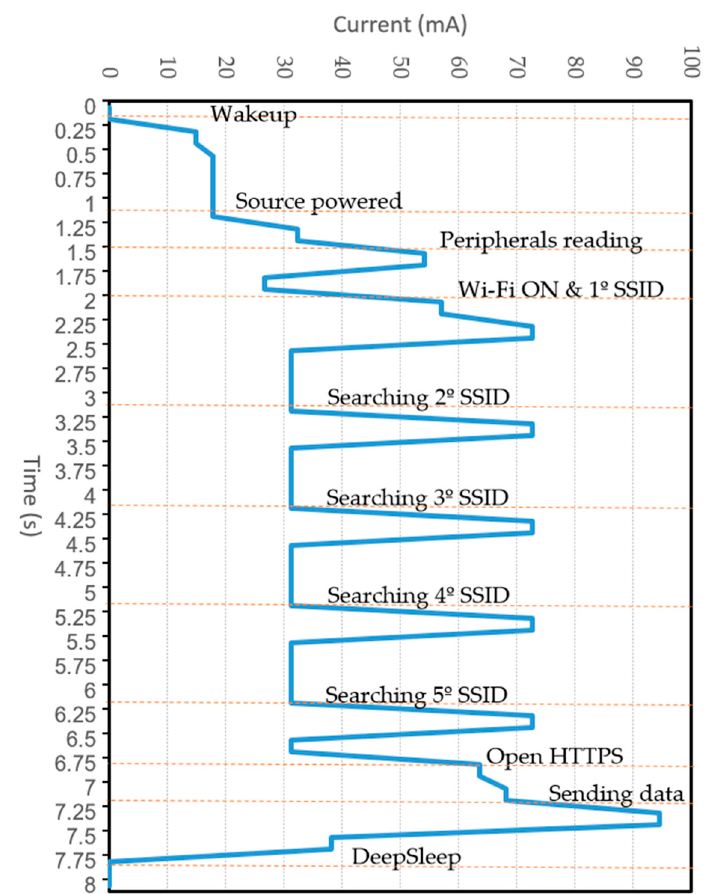
Figure 12. Power required by the different processes used in a complete execution cycle of a sensor node.